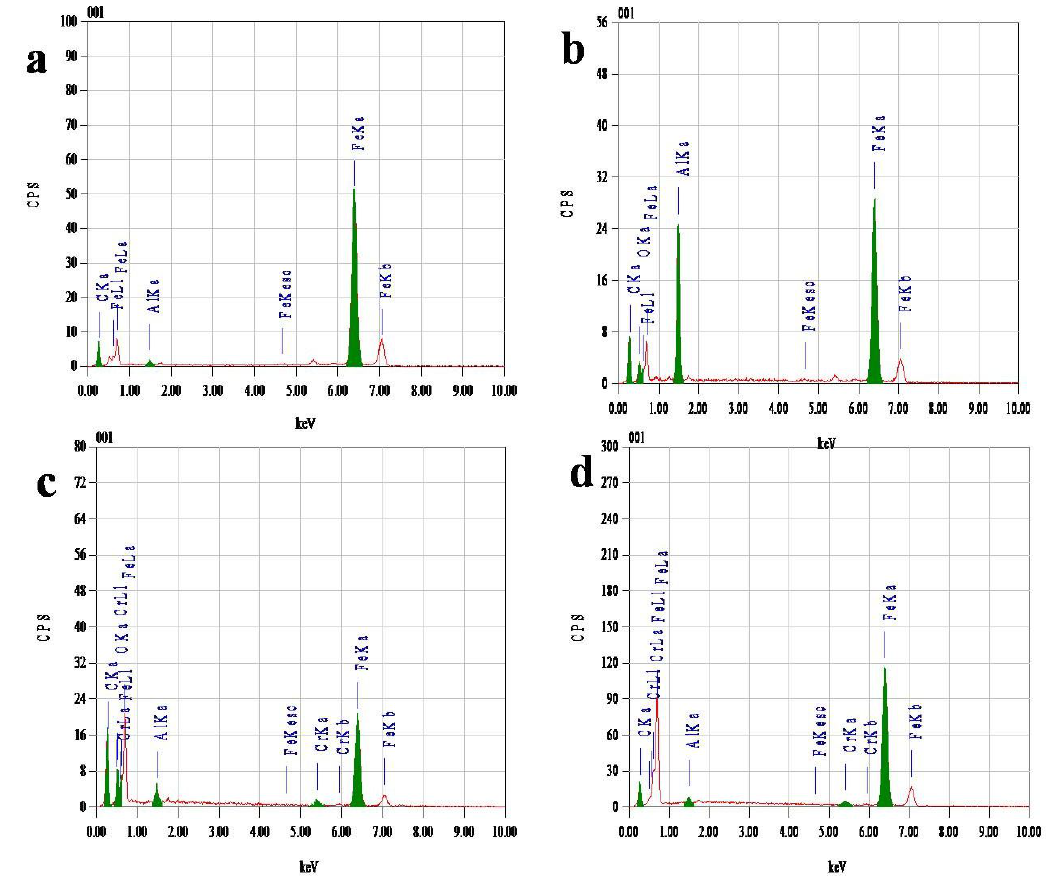
Figure 15: Energy dispersive X-ray analysis (EDX) of machined